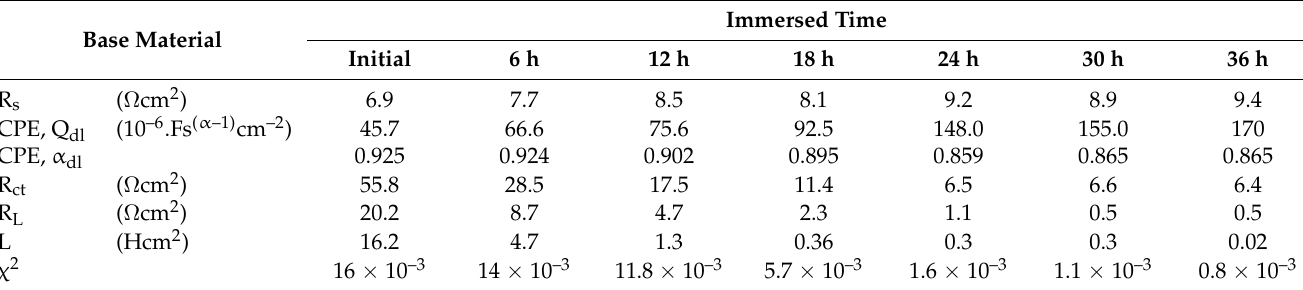
Table 5. EIS parameters for untreated, non-nitrided